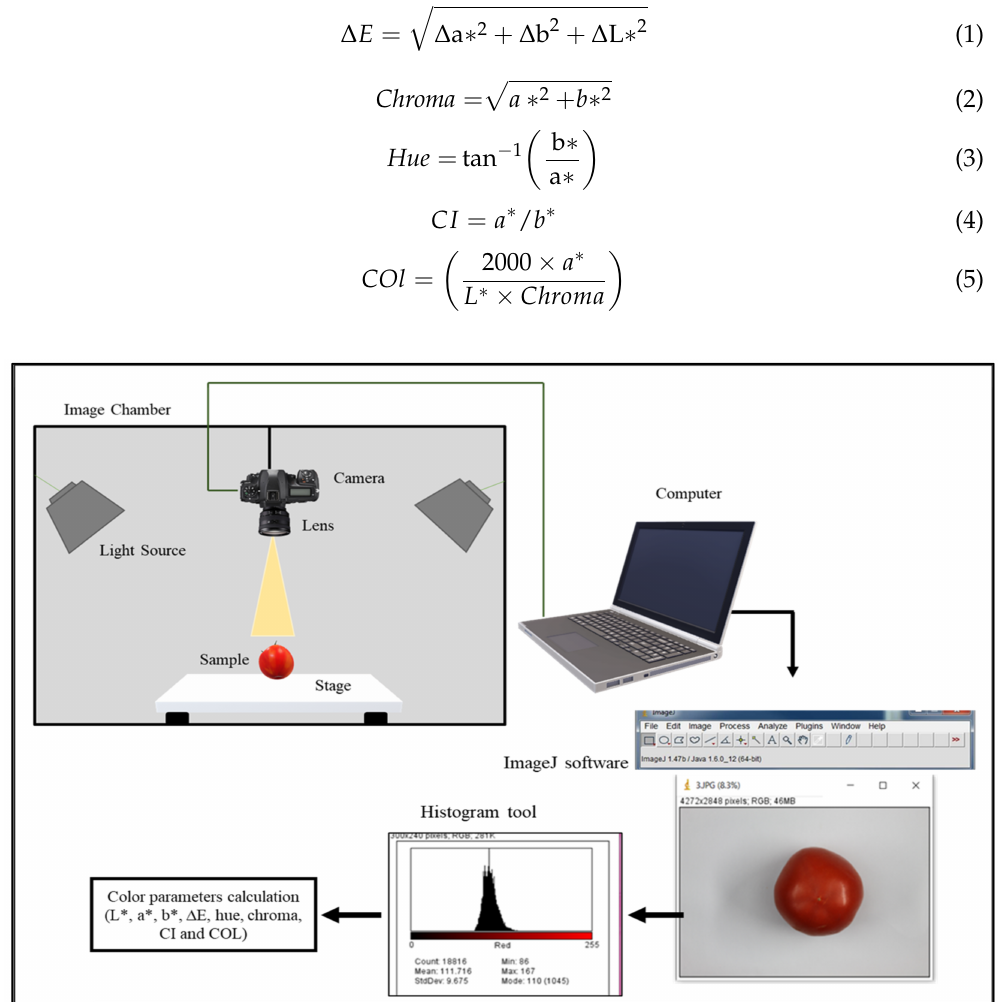
Figure 1. A schematic of a typical RGB image acquisition